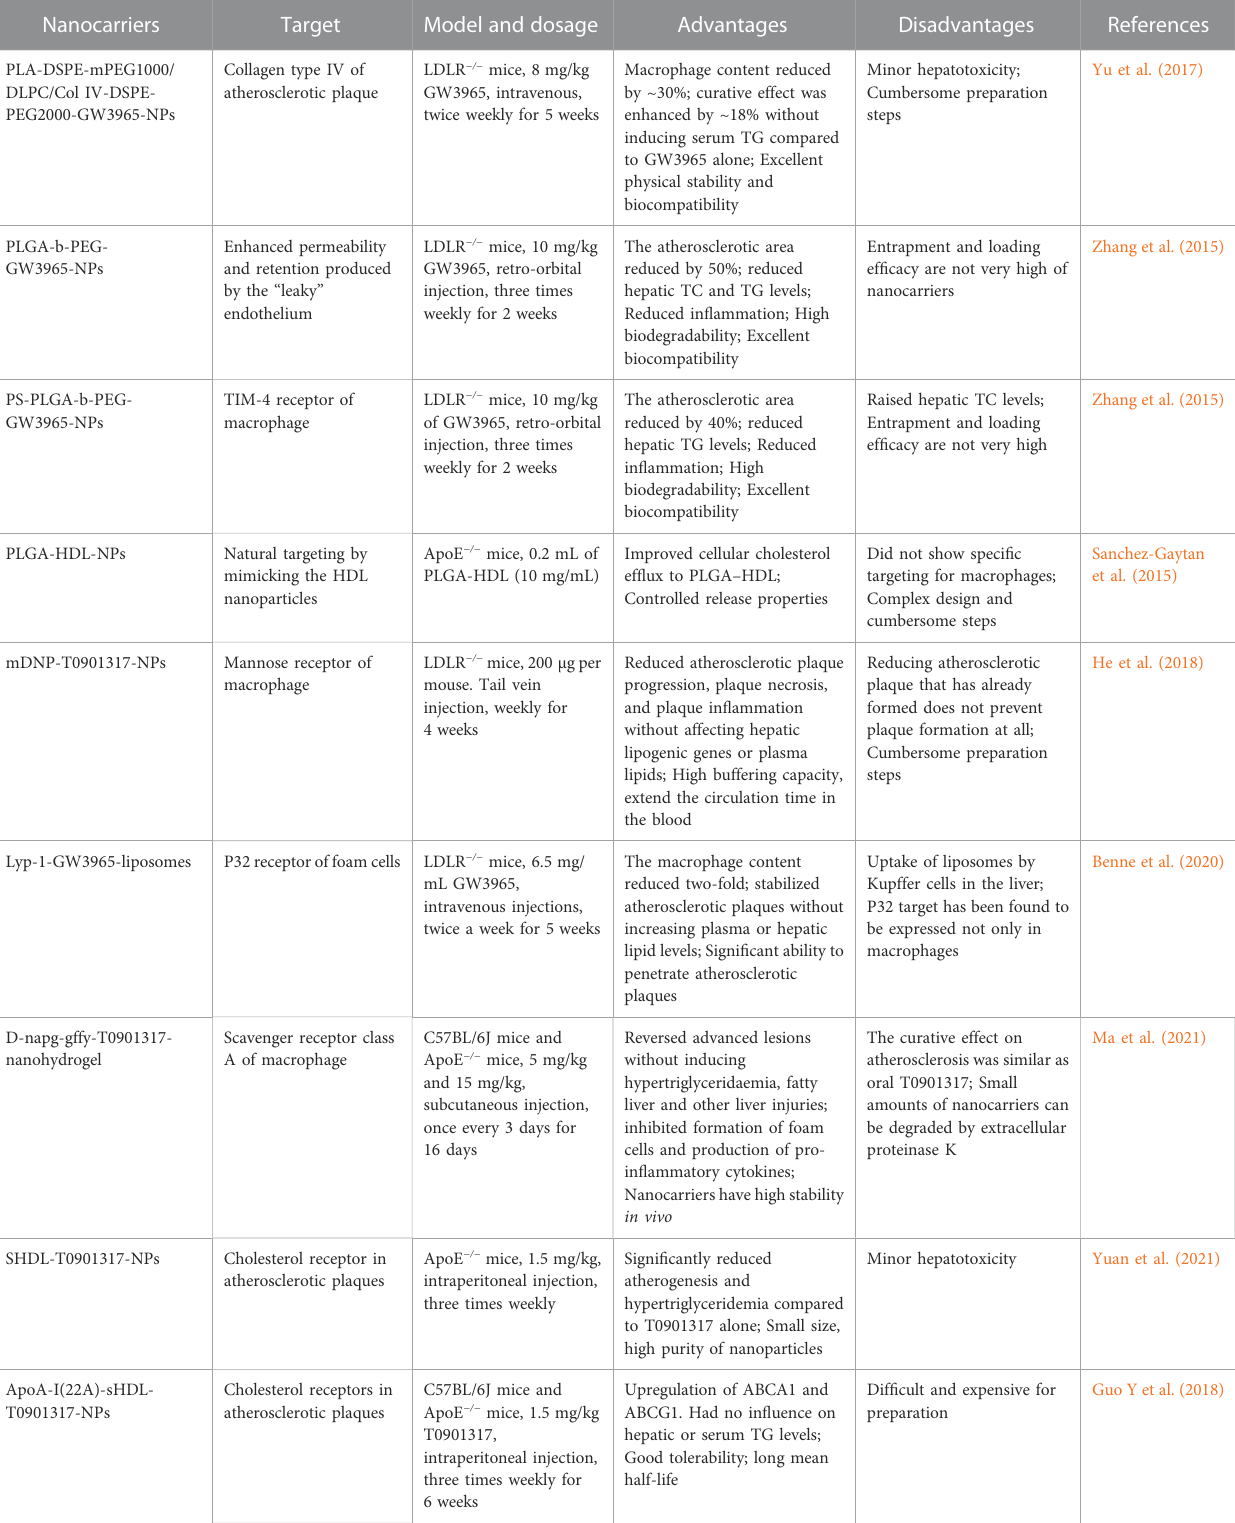
TABLE 2 Macrophage-targeted nanocarriers loaded with synthetic LXR agonists for therapy of atherosclerosis.